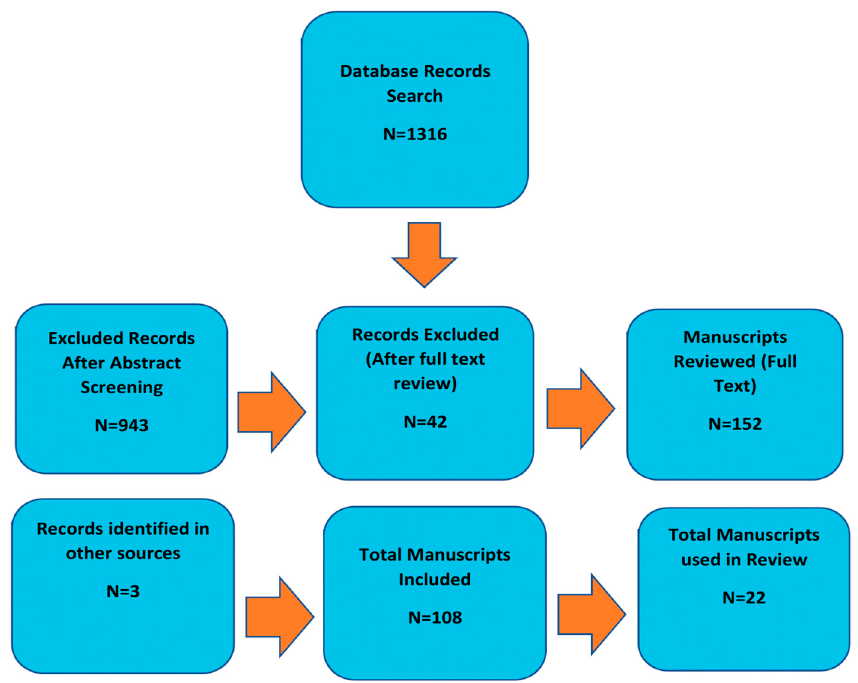
Figure 1. Flow Chart of Manuscript Identification and